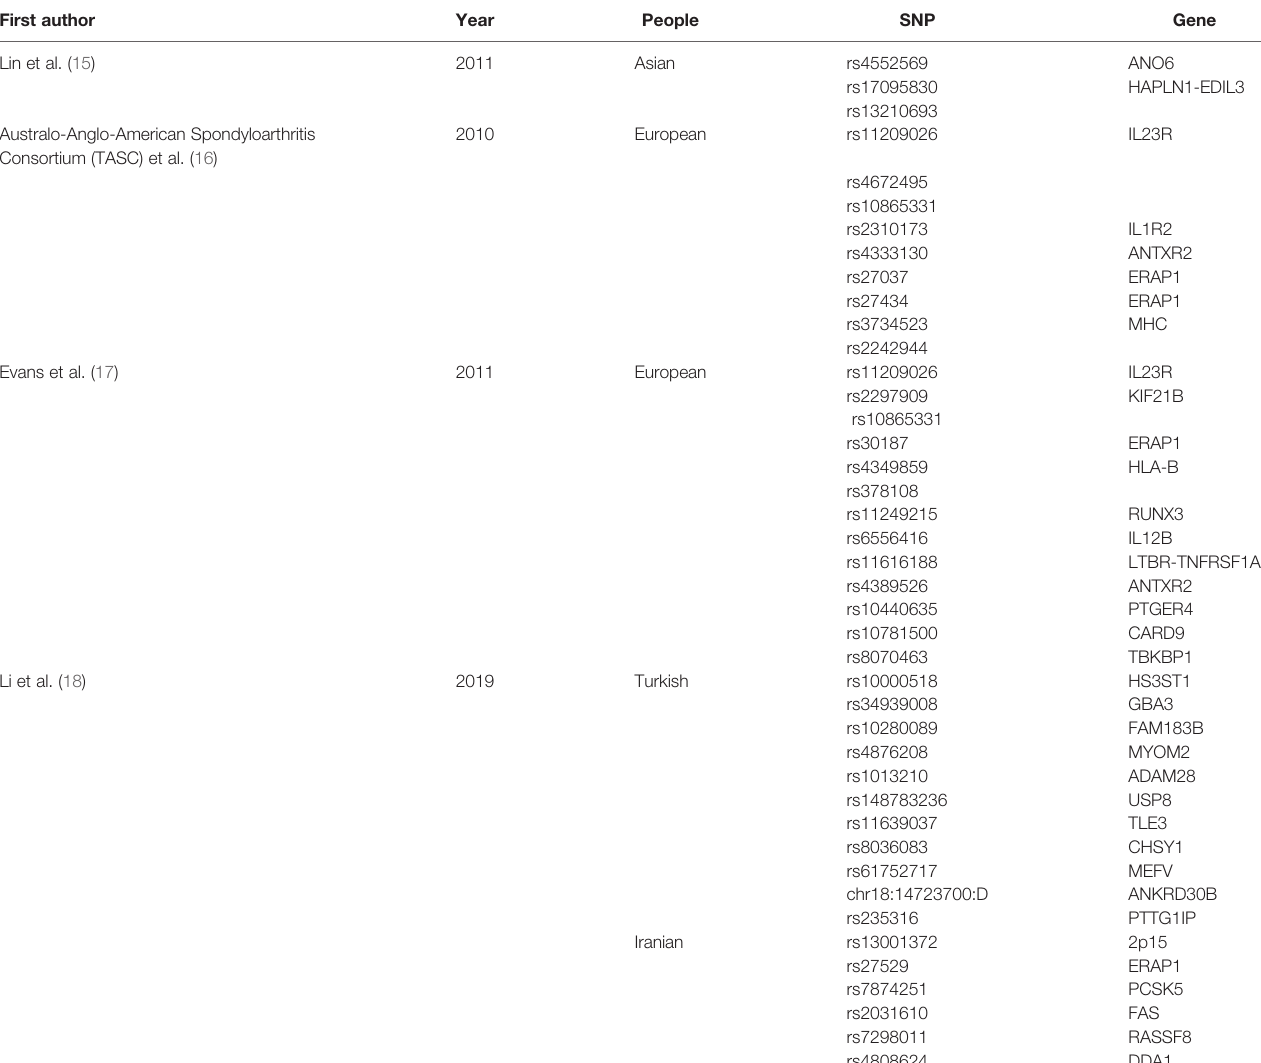
TABLE 1 | Results of previous GWAS studies on ankylosing